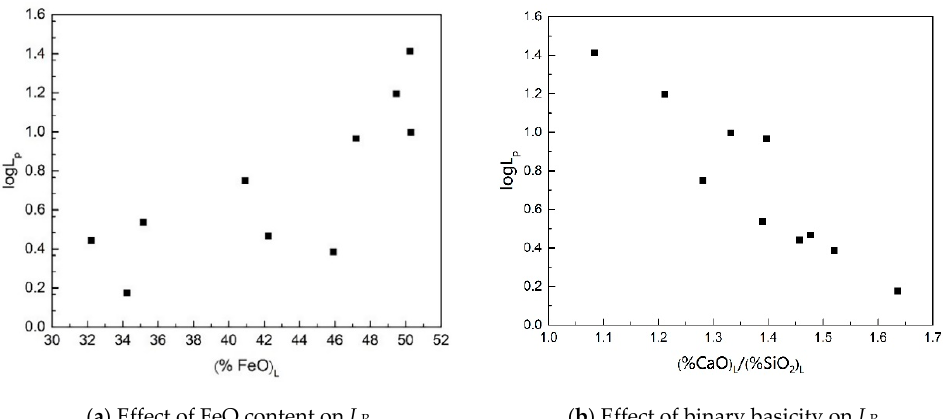
Figure 6. Effect of FeO content and binary basicity in the liquid slag phase on L P .